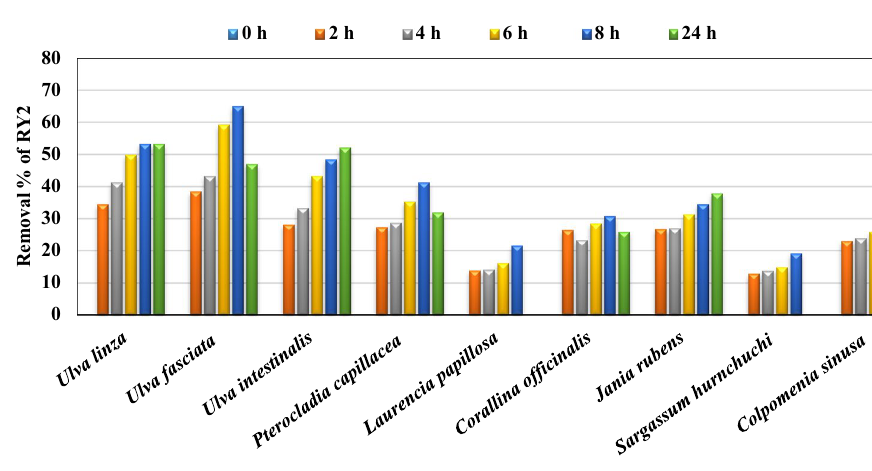
Table 8 Removal percentage of Reactive Red 195 (RR195) by the nine studied dried algal species Removal % of RR195 (λmax = 540 nm) Algae Green